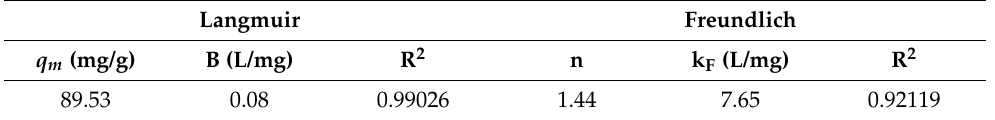
Figure 6. ( a ) Linear plot of the Langmuir adsorption isotherm, ( b ) linear plot of the Freundlich adsorption isotherm. Table 2. Isotherm parameters for CTC adsorption onto